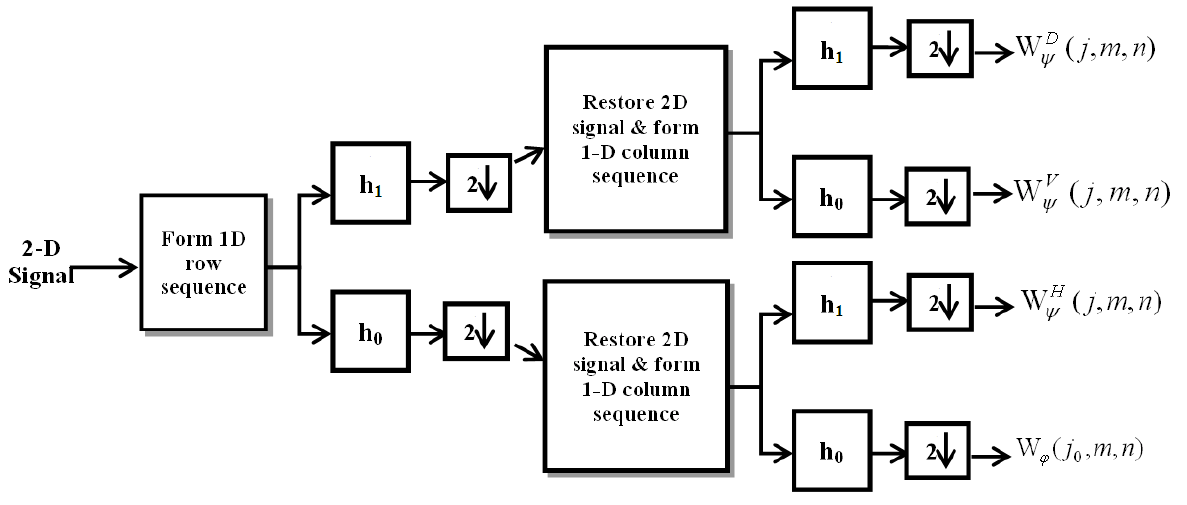
Figure 4. The analysis filterbank for 2D fast wavelet transform for one-level